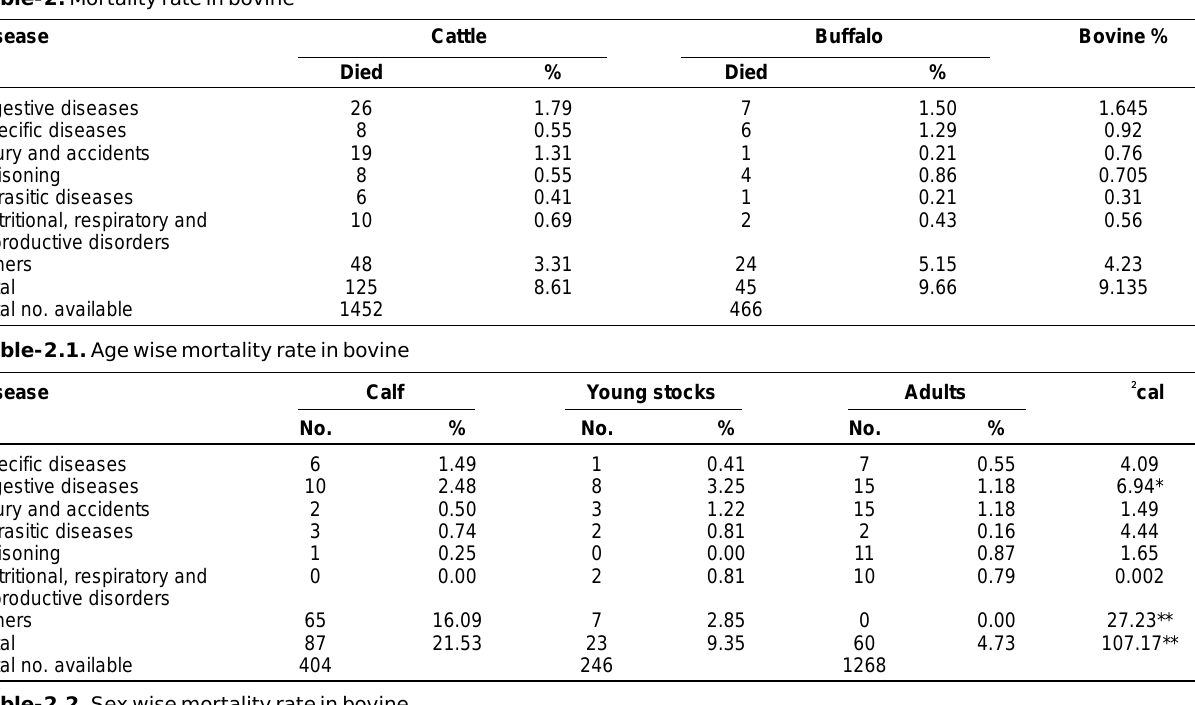
Table-2. Mortality rate in bovine Disease